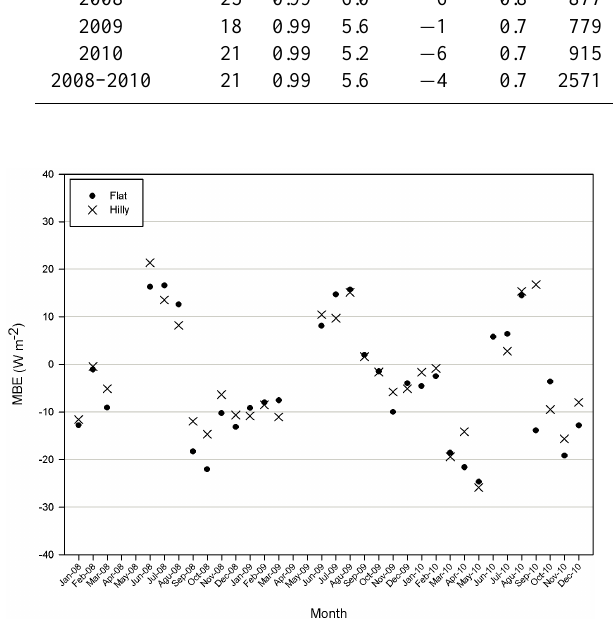
Figure 5. Monthly MBE from 2008 to 2010 in flat and hilly terrain classes. 3 Fig. 5. Monthly MBE from 2008 to 2010 in flat and hilly terrain